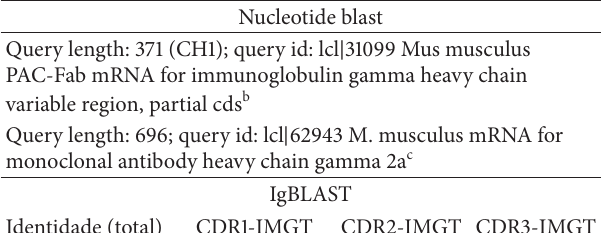
Figure3:Theepitopesanalysisof784 ∼ 968aminoacidsofP-gp.Blue underlines amino acids: the possible epitope of target protein.